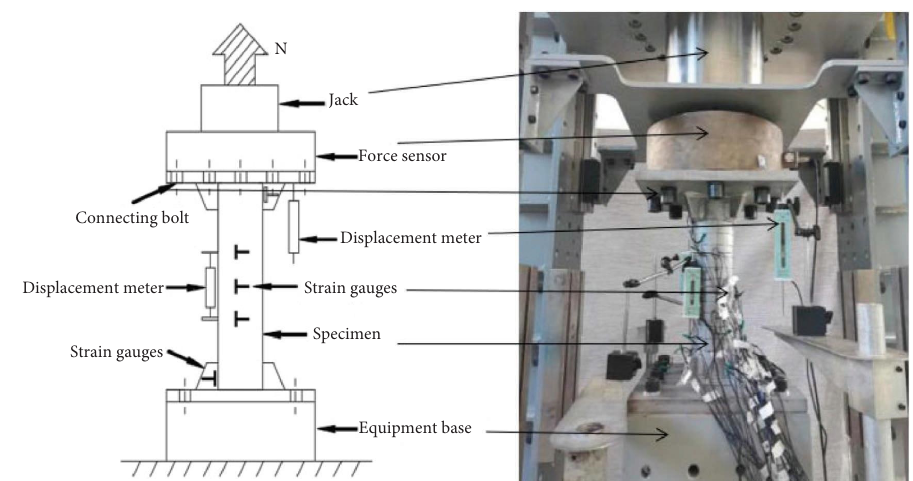
Figure 6: Experimental setup.